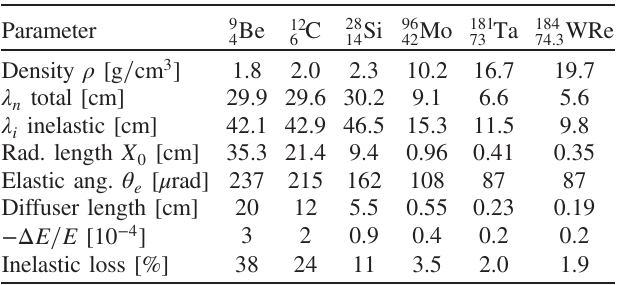
TABLE II. Diffuser length needed to achieve θ MC scattering of 400 GeV =c protons, for materials with a range of scattering